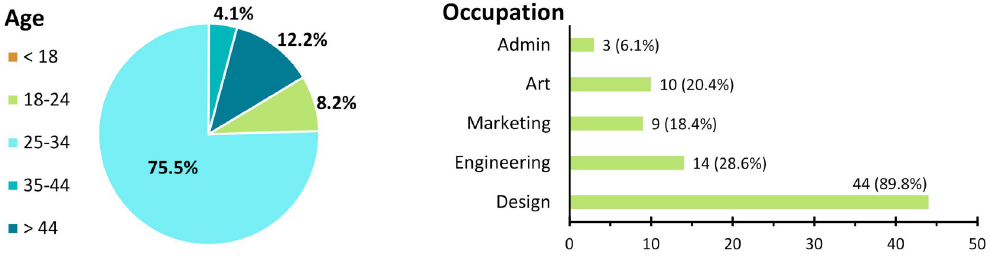
Fig 19. Survey respondents by age and field of occupation. Respondents may choose more than one